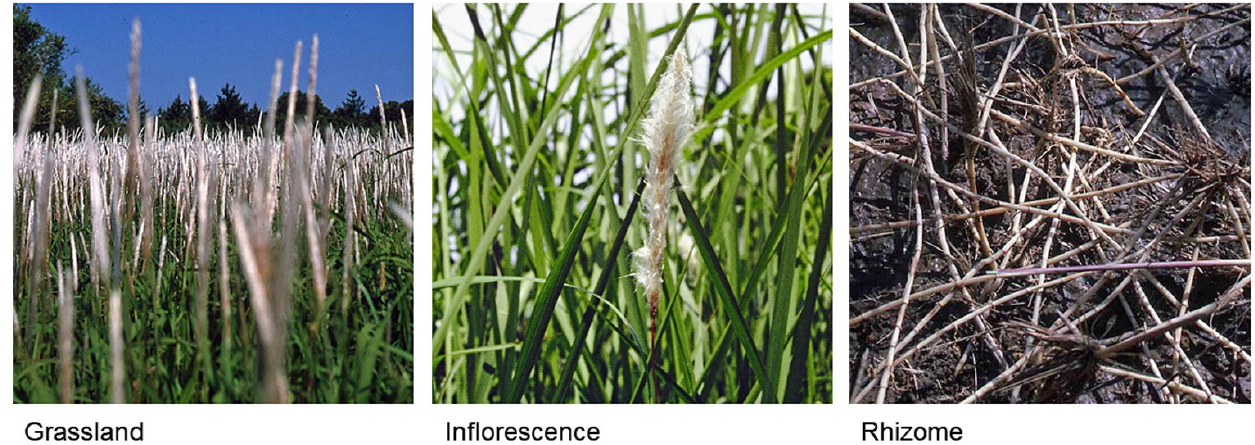
Figure 1. Imperata cylindrica . Photos were kindly provided by Dr. T. Tominaga.